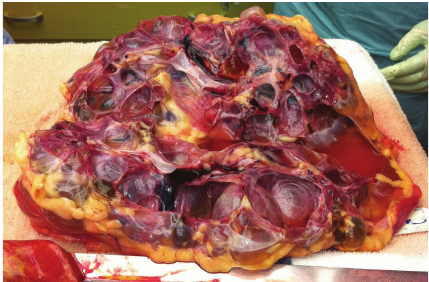
Figure 4: Left kidney, hemisectioned, showing smooth luminal